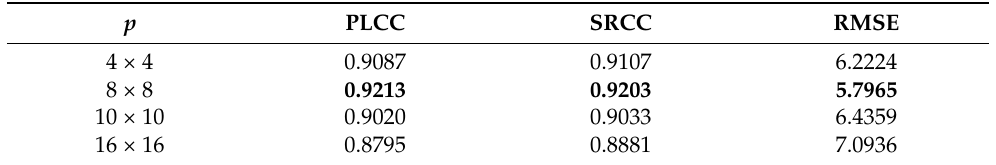
Performance results of the proposed method with different atom sizes on the SIQAD